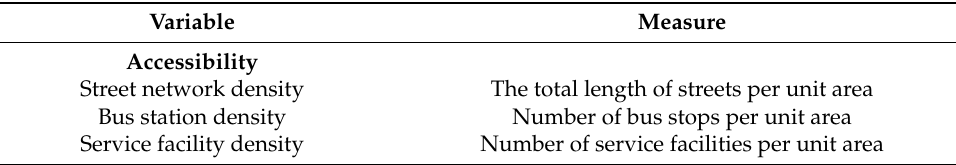
Table 4. Variables and measures of the residential built